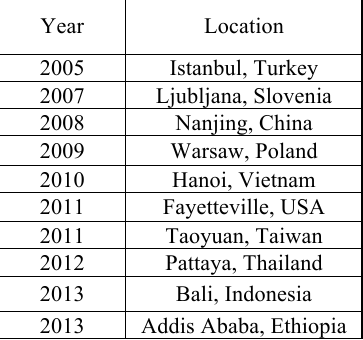
Table 1. Summary of the locations of SC summer schools organised from 2005 to 2013.